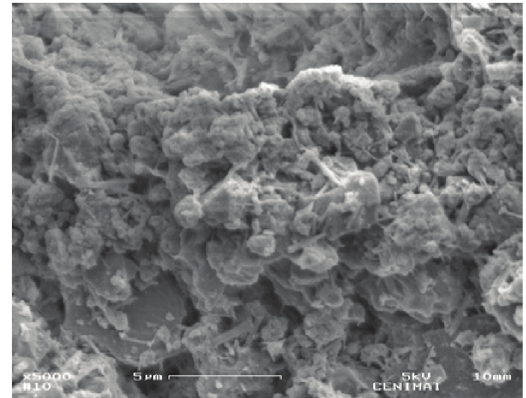
Fig. 5. SEM image of 7-days hardened grout without additives (mix 1) at 5000x